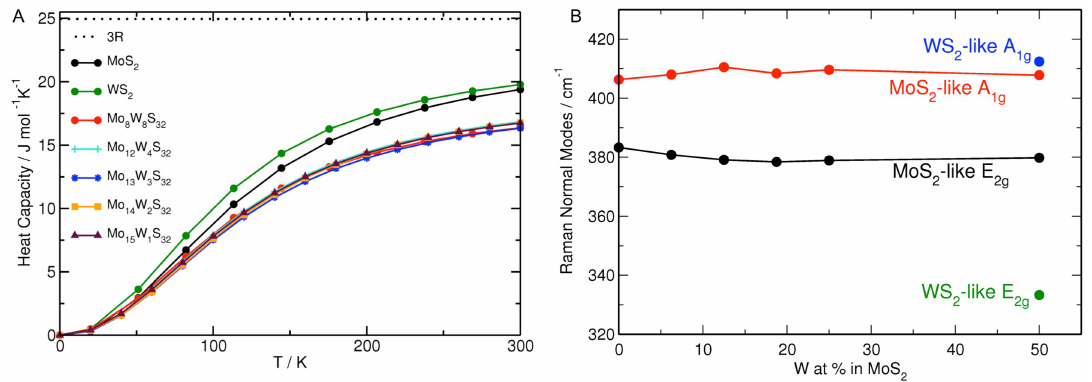
Figure 6. ( A ) Heat capacity and ( B ) Raman normal modes change with the W concentration in the MoS 2 monolayer. The normal modes are indicated.